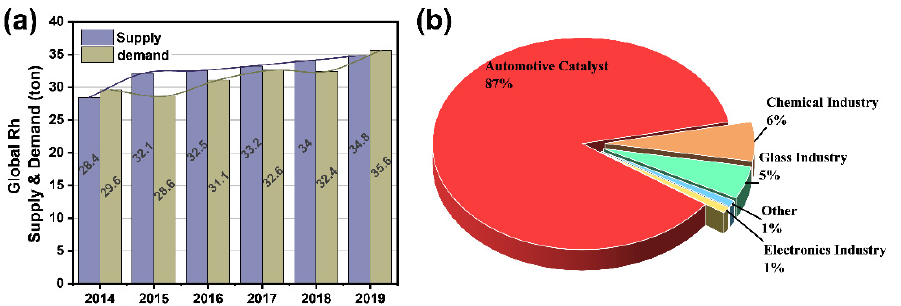
Figure 1. ( a ) Global Rh supply/demand from 2014 to 2019. ( b ) Global consumption profile of Rh in 2019.